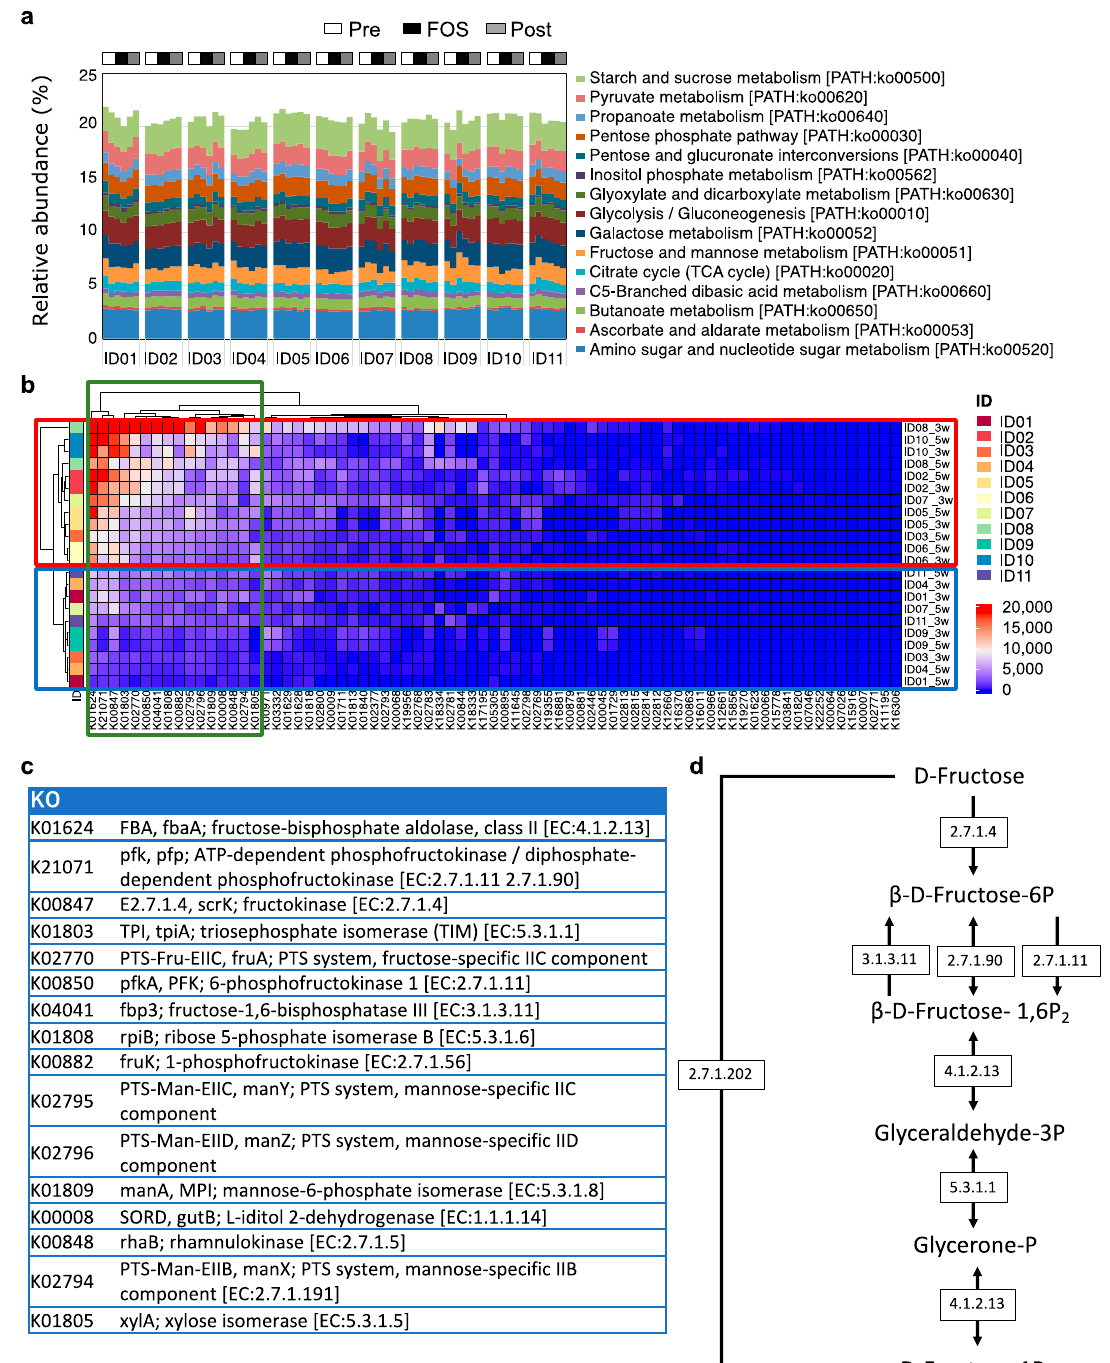
Figure 3. KEGG pathways in carbohydrate metabolism with the metagenomic analysis. ( a ) Relative abundance of the KEGG orthologies (KOs) associated with carbohydrate metabolism in fecal samples was inferred based on the metagenome analysis. ( b ) A comparison of KOs of the fructose and mannose metabolism pathways in individuals obtained from the metagenome analysis of fecal samples using a heatmap calculated by multiplying individual metagenomic genes and a number of bacteria. The green rectangle indicates the gut microbial fructose and mannose metabolism KOs with high variability, and red and blue rectangles indicate groups of individuals having relatively higher and lower expressions of these highly variable KOs, respectively. ( c ) A list of 16 KOs with high individual variability in gene expression that was identified from ( b ). ( d ) Summary of a metabolic pathway that involves many KOs listed in ( c